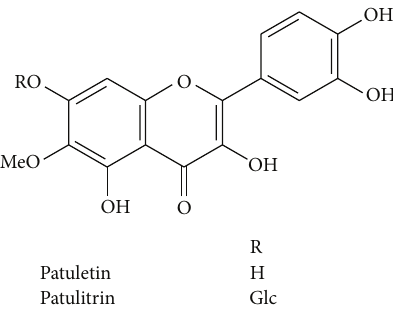
Figure 1: The structures of flavonoids from Tagetes putula